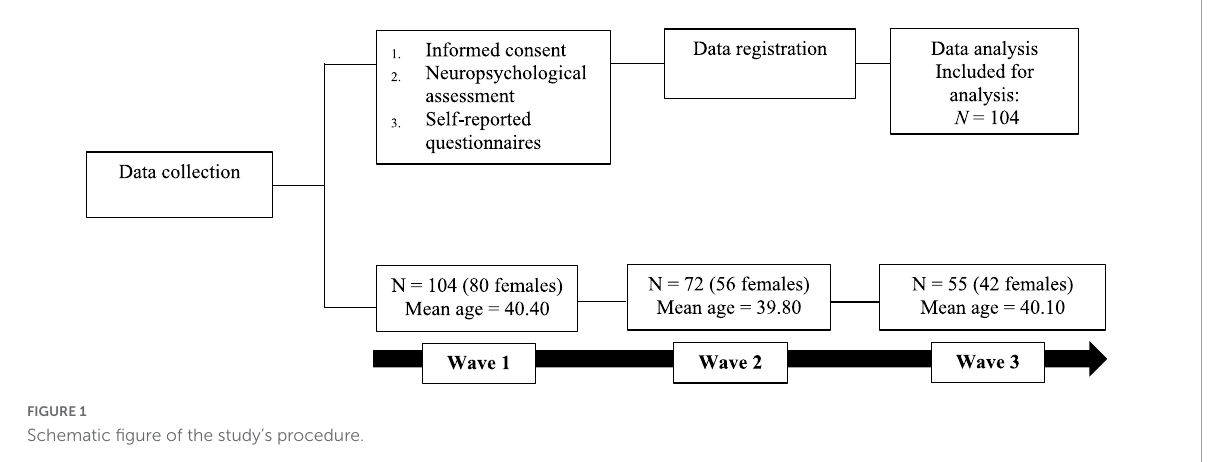
FIGURE1 Schematic figure of the study’s procedure.